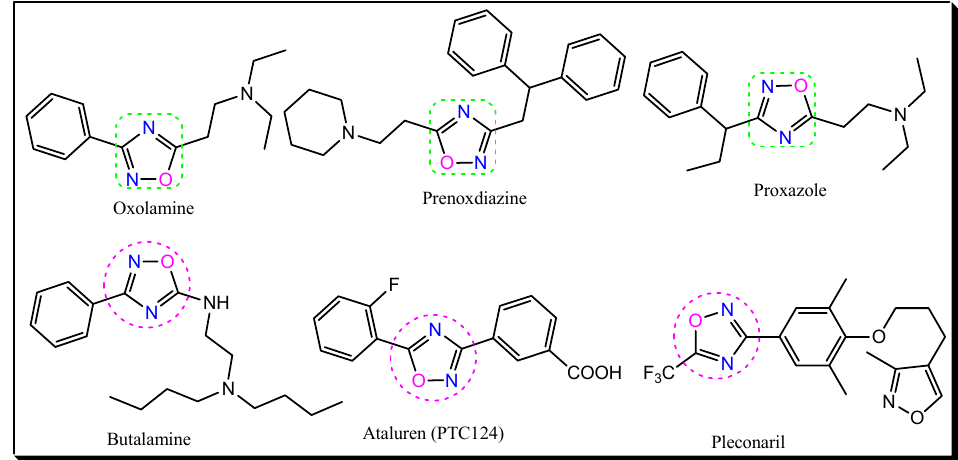
Figure 3. Chemical structures of drugs based on a 1,2,4-oxadiazole moiety. Ataluren (PTC124) is a drug for the treatment of Duchenne muscular dystrophy. It was designed by PTC Therapeutics and is sold under the trade name Translarna in the European Union. Chemically, it is 3-[5-(2-fluorophenyl)-1,2,4-oxadiazol-3-yl]benzoic acid. Pleconaril is an antiviral drug. It exhibits its action by inhibiting viral replication. It was developed by Schering-Plough for the prevention of asthma exacerbations and common cold symptoms in patients exposed to picornavirus respiratory infections. Chemically, it is 3-[3,5-dimethyl-4-[3-(3-methyl-1,2-oxazol-5-yl)propoxy]phenyl]-5-(trifluoromethyl)-1,2,4-oxadiazole [22–24]. Carbone M. et al. isolated two indole alkaloids, phidianidine-A and phidianidine-B (Figure 4), from sea slug opisthobranch Phidiana militaris. Chemically, phidianidine-B is 2-[5-[[5-(1H-indol-3-ylmethyl)-1,2,4-oxadiazol-3-yl]amino]pentyl]guanidine. Both phidianidines exhibit in vitro cytotoxic activity against tumor and non-tumor mammalian cell lines (rat glial-C6, human cervical-HeLa, colon adenocarcinoma-CaCo-2, mouse embryo-3T3-L1 and rat heart myoblast-H9c2) [25]. Similarly, quisqualic acid is a naturally occurring compound bearing 1,2,4-oxadiazole moiety. It is obtained from seeds of Quisqualis indica. It is usedfor the treatment of stroke, epilepsy and neurodegenerative disorders [26,27].